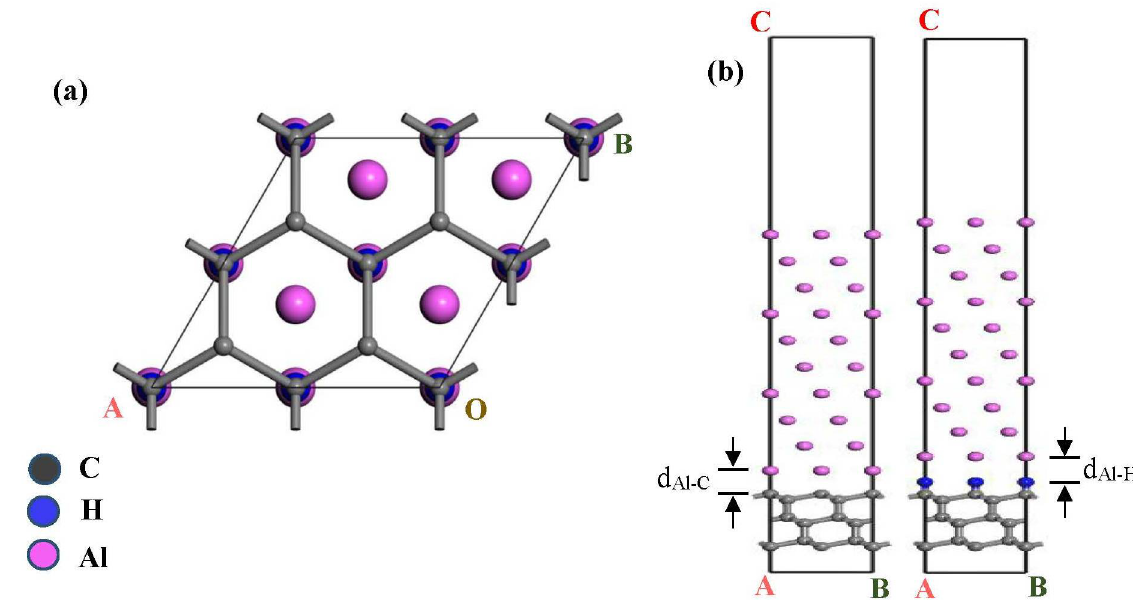
Figure 6. The interface model used in the first-principles calculations: ( a ) Top view of the interface registry, where the edge length of the cell is 5.05 Å. ( b ) Side view of the interface model formed between 10 layers of Al and 6 layers of diamond/diamond surface terminated with hydrogen, where d Al-C is the distance between the Al and C atoms and d Al-H is the distance between the Al and H atoms at the interface.